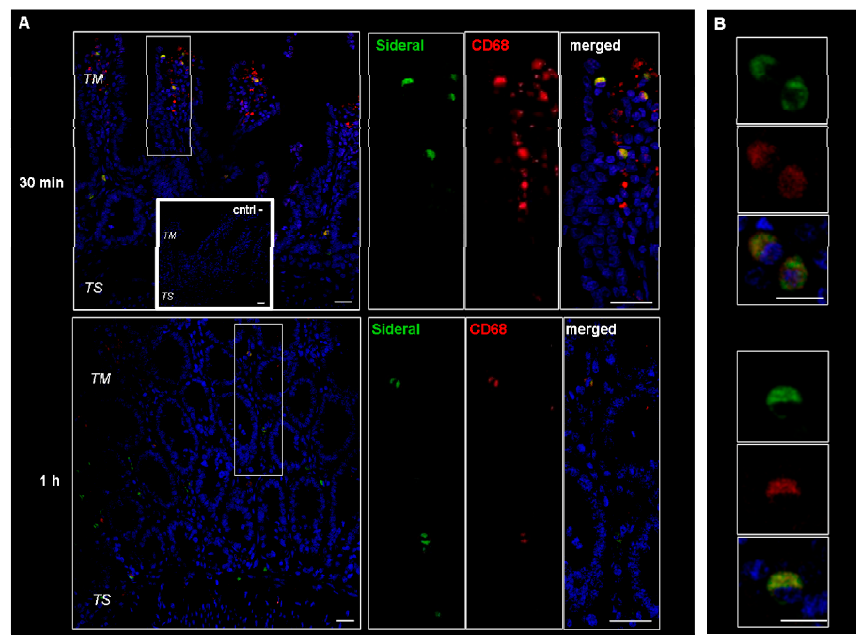
Figure 3. Confocal laser scanning microscopy: representative images of rat gut sections after 0.5 and 1 h incubation in Ussing chamber. Negative controls obtained omitting primary antibodies are shown in double line squares. Individual fluorescent channels: green (SRM), red (CD68 + cells) and blue (nuclei). ( A ) Bidimensional image of the maximum intensity projection. Scale bar 25 µm. ( B ) Images acquired in one Z-plane (29th of 47 and 26th of 40, incubated 0.5 and 1 h, respectively) at a magnification of different sections higher than that of (A). Scale bar 10 µm.